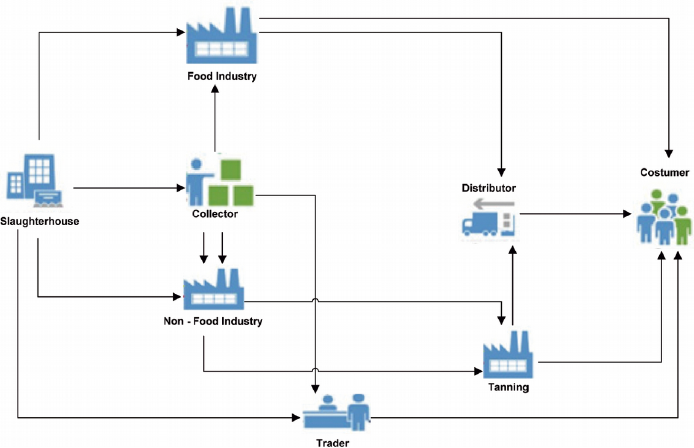
Figure 1. Business units of cowhide products in Indonesia